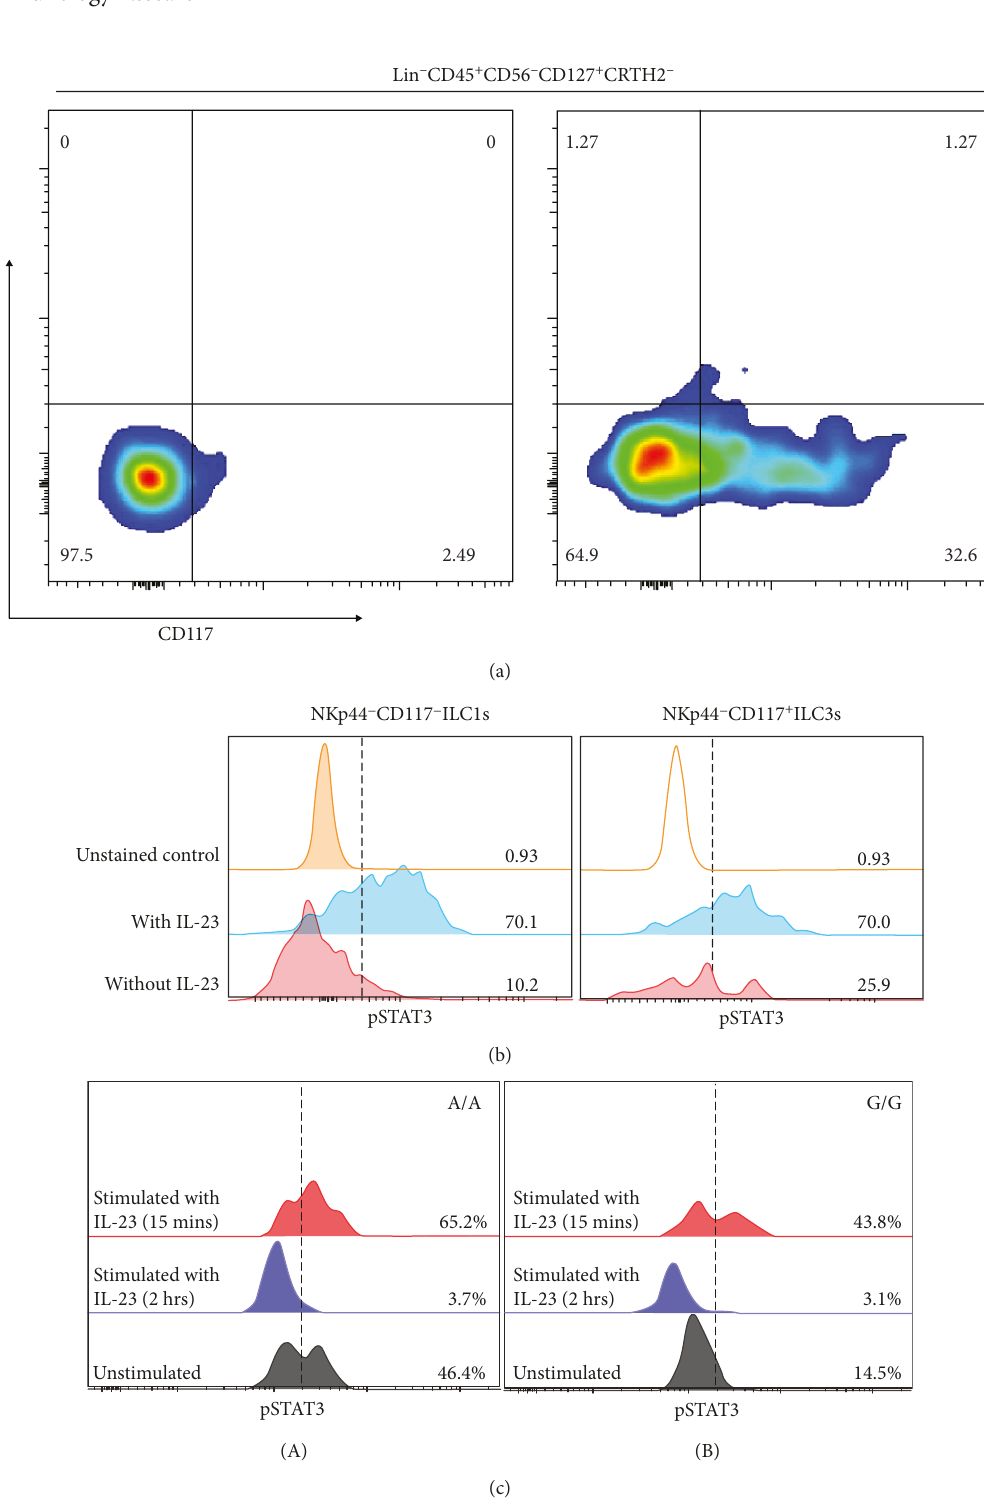
Figure 4: Activation of STAT3 signaling in innate lymphoid cells in response to IL-23 stimulation. (a) PBMCs from healthy donor were stimulated by 20 ng/ml of IL-23 for 15 minutes. After gating Lin - CD45 + CD127 + CRTH2 - cells, the ILC population was further gated based on CD117 and NKp44 expression. The CD117 + NKp44 - ILC3 population (NCR - ILC3 phenotype) was induced by IL-23 stimulation. (b) IL-23 activated STAT3 signaling in both the CD117 - NKp44 - ILC1 and CD117 + NKp44 - ILC3 subsets. (c) After gating Lin - CD45 + CD56 + CD127 + CRTH2 - ILCs, the tyrosine phosphorylation level of STAT3 was evaluated in ILCs. Donor with A/A genotype was shown in (A), and donor with G/G genotype was demonstrated in (B). The pSTAT3 level after 15 mins or 2 hrs stimulation of IL-23 indicated there was no delayed dephosphorylation in donors, suggesting risky allele “ A ” carriage does not a ff ect the dephosphorylation of STAT3 in